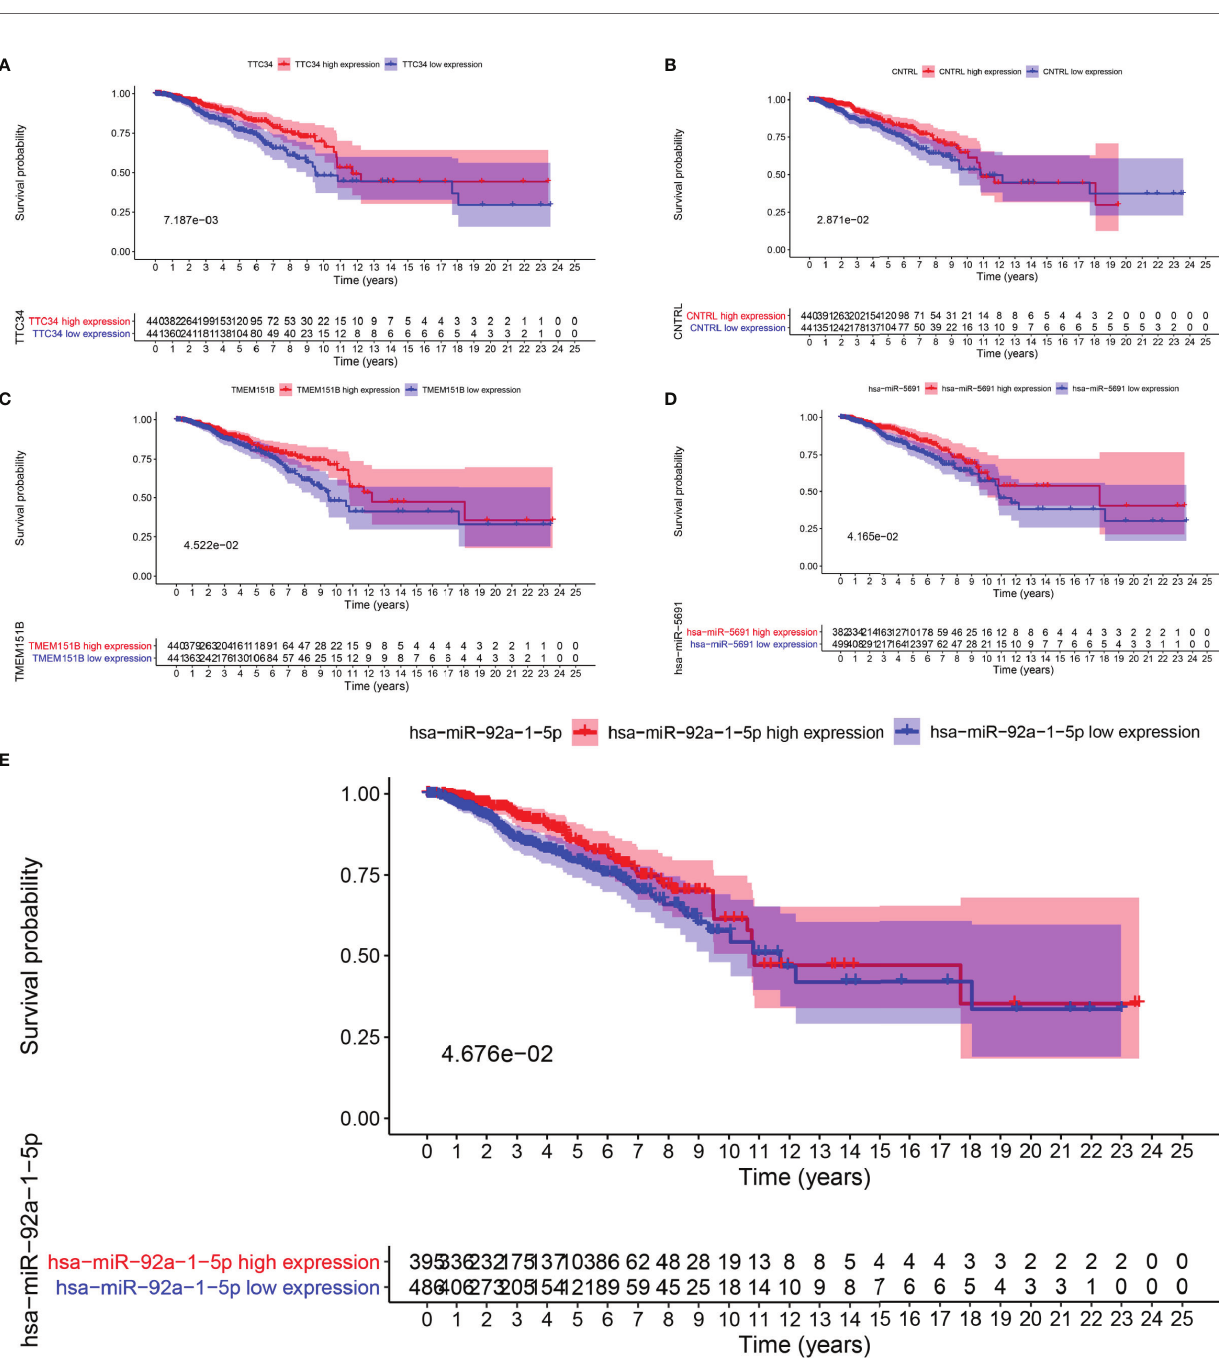
FIGURE 4 | Kaplan – Meier survival curves of whose higher expression showed the higher OS. TTC34 (A) , CNTRL (B) , TMEM151B (C) , hsa-miR-5691 (D) , hsa-miR- 92a-1-5p (E)